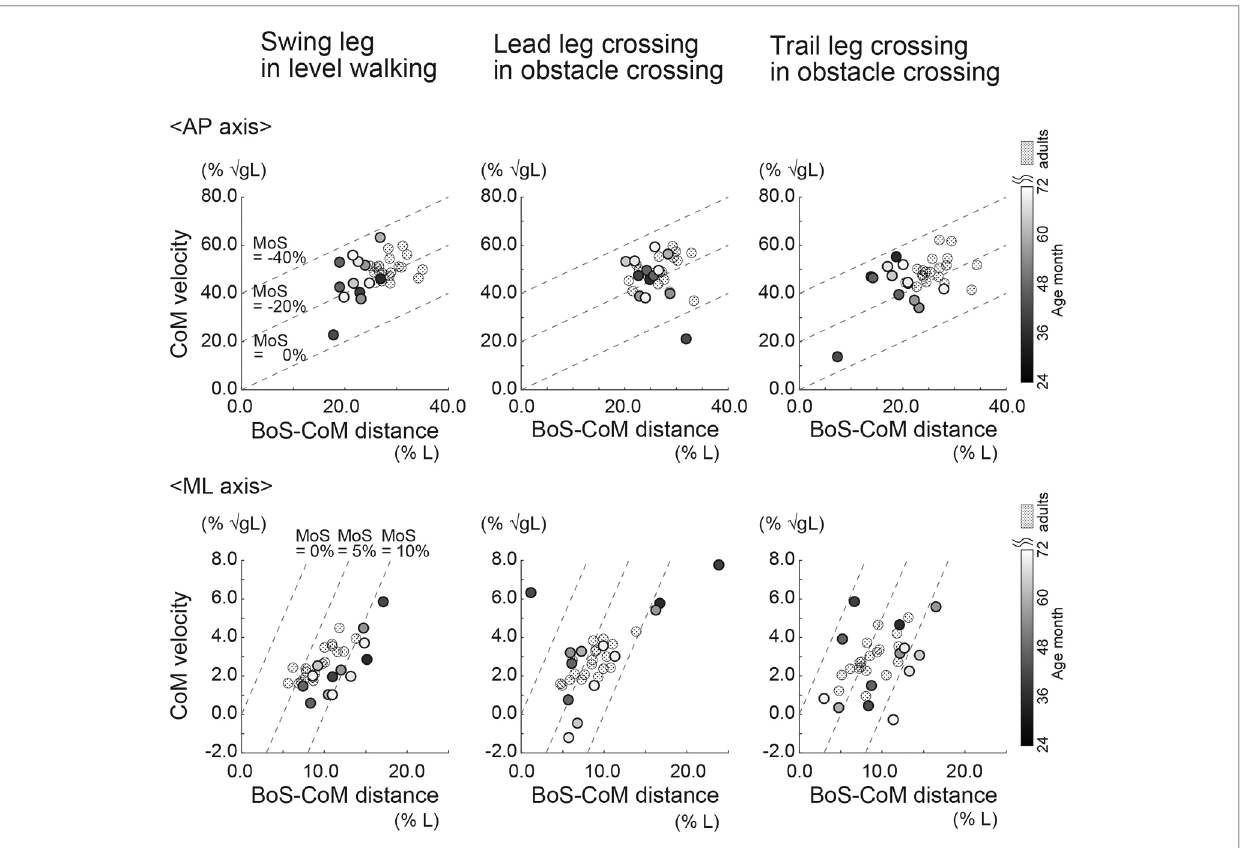
FIGURE 6 Normalized base of support (BoS)-center of mass (CoM) distance and CoM velocity in the anteroposterior (AP) and mediolateral (ML) directions during level walking and obstacle crossing (with the lead and trail leg, separately). The BoS-CoM distance was normalized to leg length ( L ). The CoM velocity was normalized to the root square of gravity ( g )× L . Circles indicate the mean value of each